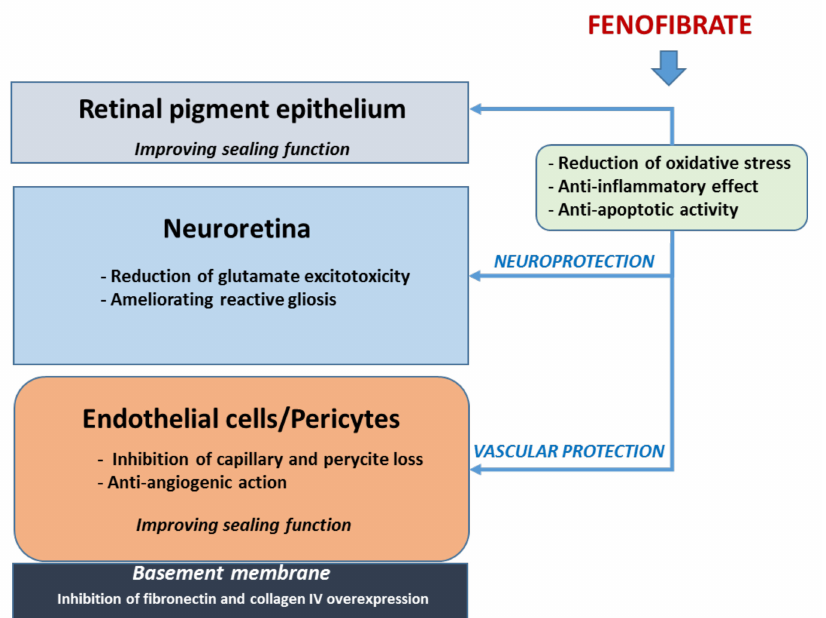
Figure 1. Main non-lipidic mechanisms involved in the beneficial effects of fenofibrate in DR. There are common mechanisms such as the anti-oxidant, anti-inflammatory, and anti-apoptotic actions that take place in the entire retina. However, other actions are only localized in the neuroretina (reduction in glutamate excitotoxicity and reactive gliosis), in vascular cells (inhibition of capillary and pericyte loss), or in the basement membrane (reduction in fibronectin and collagen IV overexpression). As a global consequence, an improvement of sealing function of both outer an inner blood–retinal barrier occurs, thus preventing or arresting the vascular